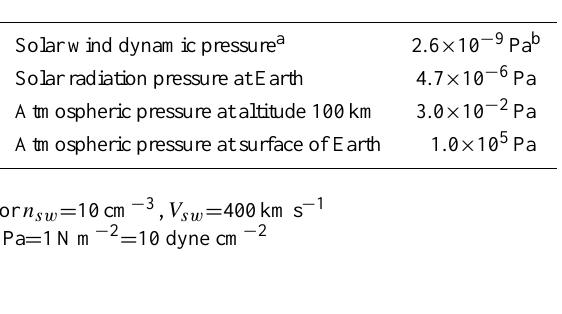
Table 2. Pressures in the Earth-ionosphere-magnetosphere